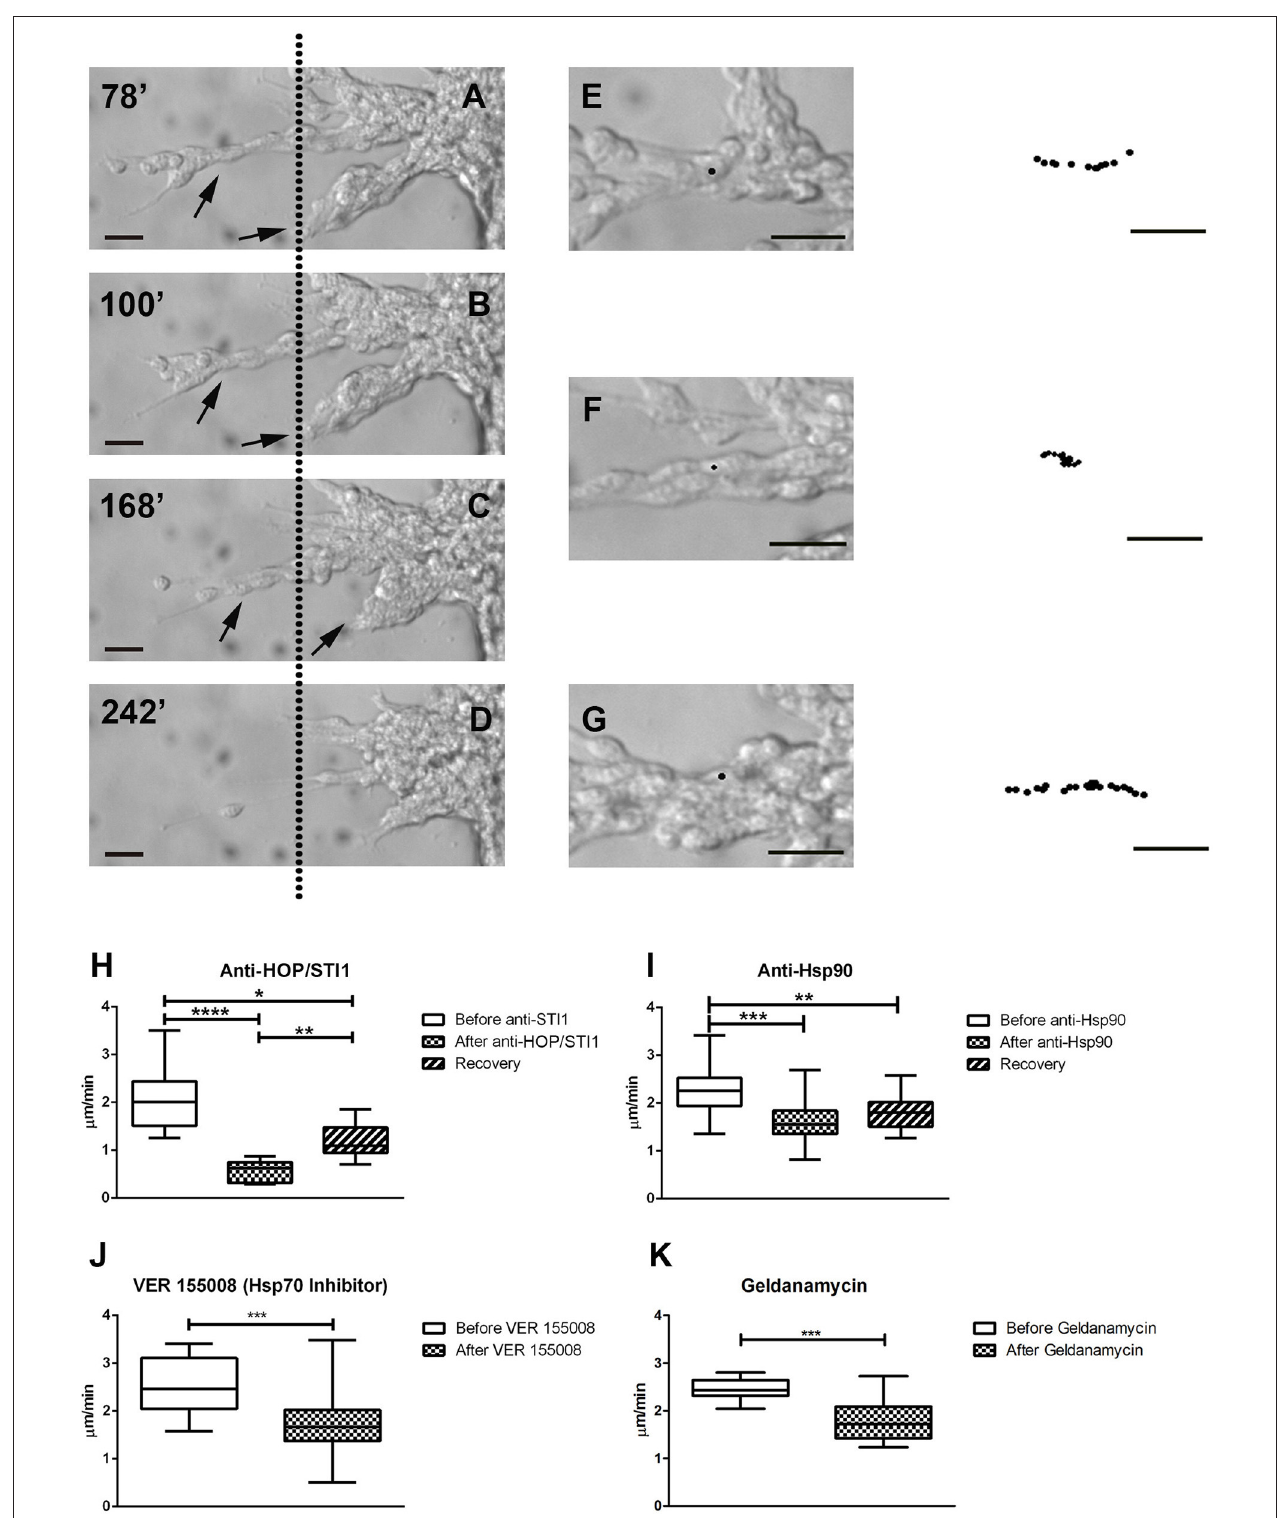
FIGURE 4 | Time-lapse videomicroscopy demonstrates collapse of migratory chains and decrease in average cell migratory speed. In A–D , after anti-HOP/STI1 treatment, individual cells within chains are nearly indistinguishable, as the cells cluster into compact masses in the proximity of explants.